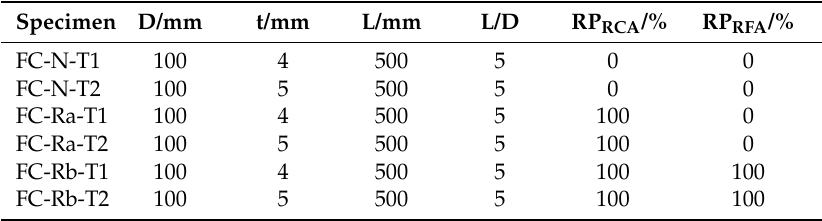
Table 2. Parameters of second group.